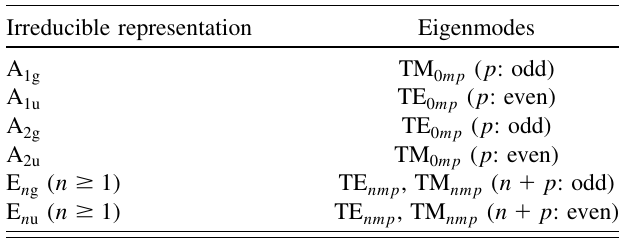
TABLE I. Character table for the point group D 1 Irreducible representation